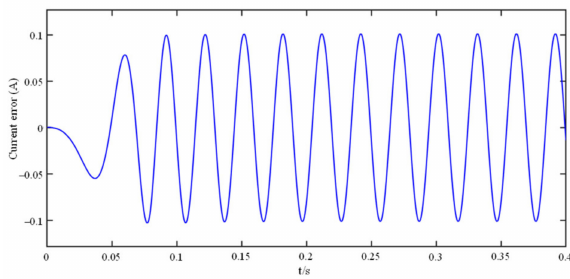
Figure 24. The current error graph when R = 0.1326 Ω .